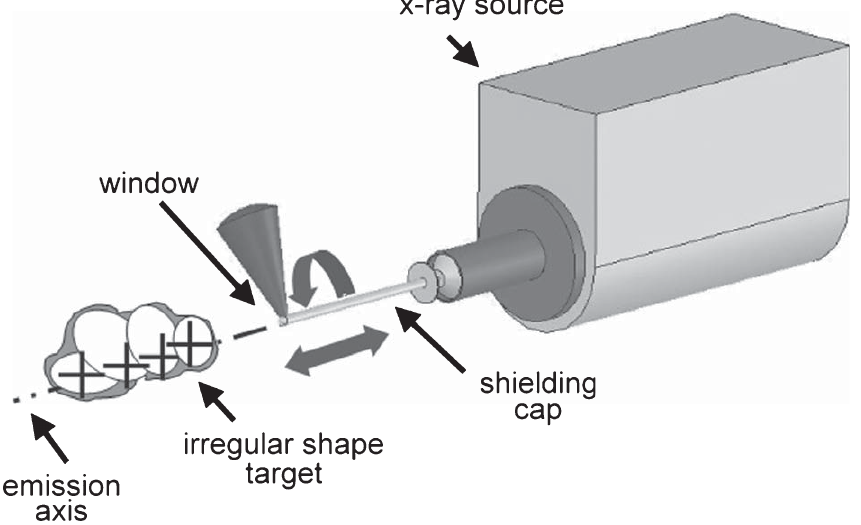
Fig. 6. Innovative treatment with PRS and conformal caps.